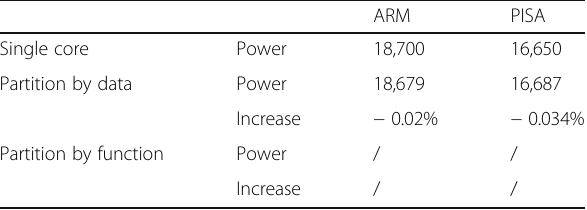
Table 3 Peak power consumption during program operation (sampling every 1 k cycle)